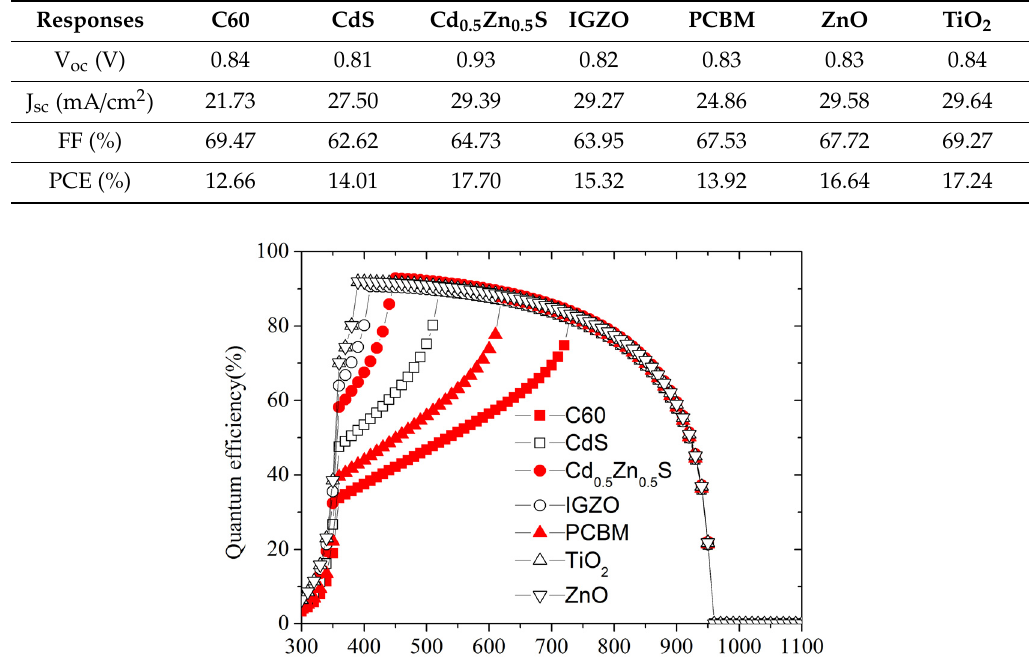
Table 4. Responses of PSCs with di ff erent ETL materials.